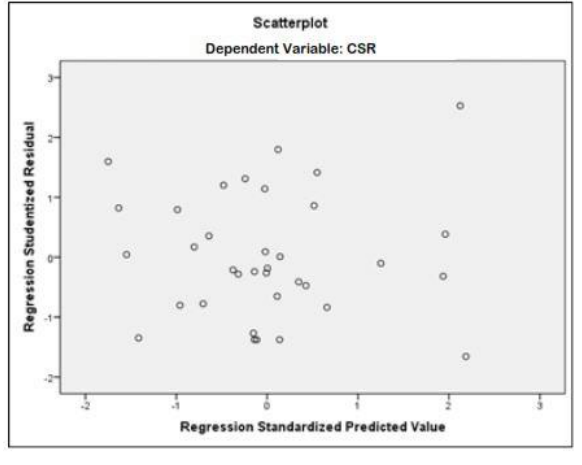
Figure 1: Heteroscedasticity Test Results; Source: processed data